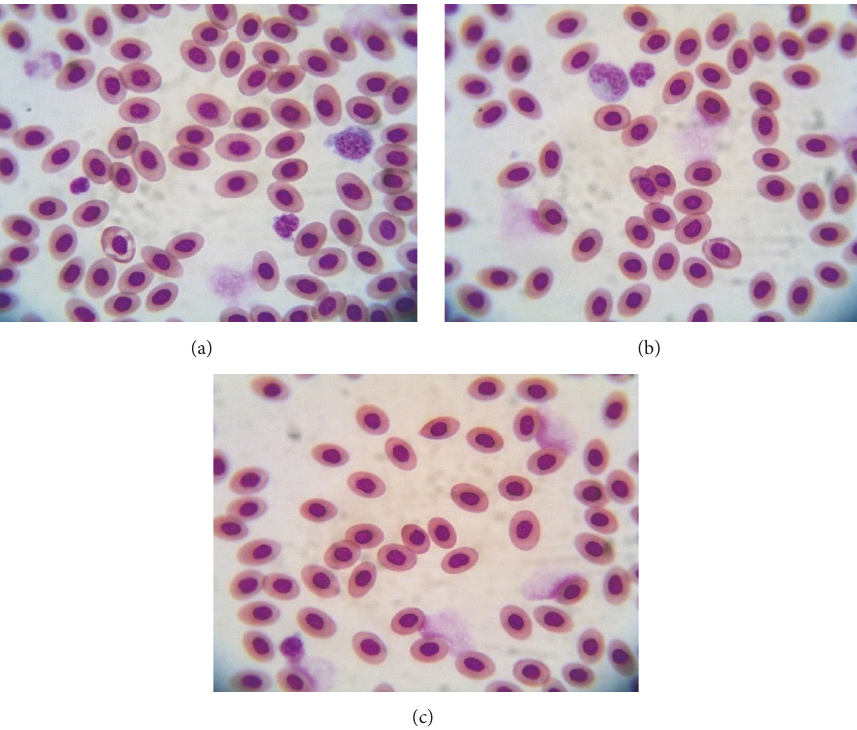
Figure 2: Photomicrographs of erythrocytes of the chickens fed a diet naturally contaminated with AF on day 21. The normal appearance of erythrocytes with a uniform size in group I (a); group II (b); pale colour and predominant small size of erythrocytes in group VI that indicates normocytic-hypochromic anaemia (c). Giemsa, 1000 × .